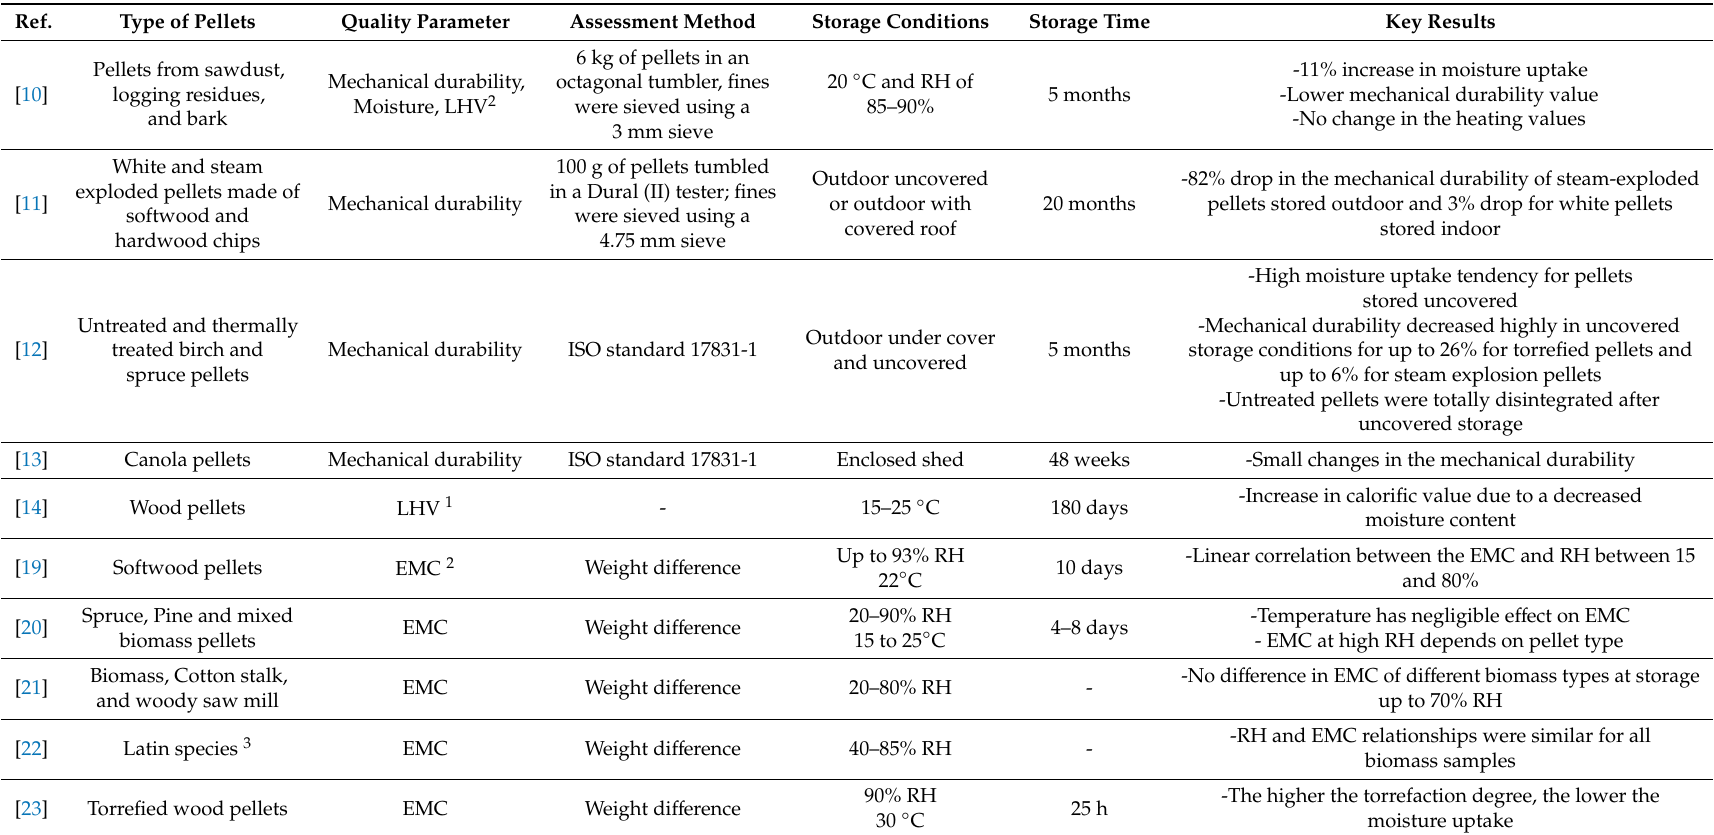
Table 1. Literature review of the quality parameters of biomass pellets after